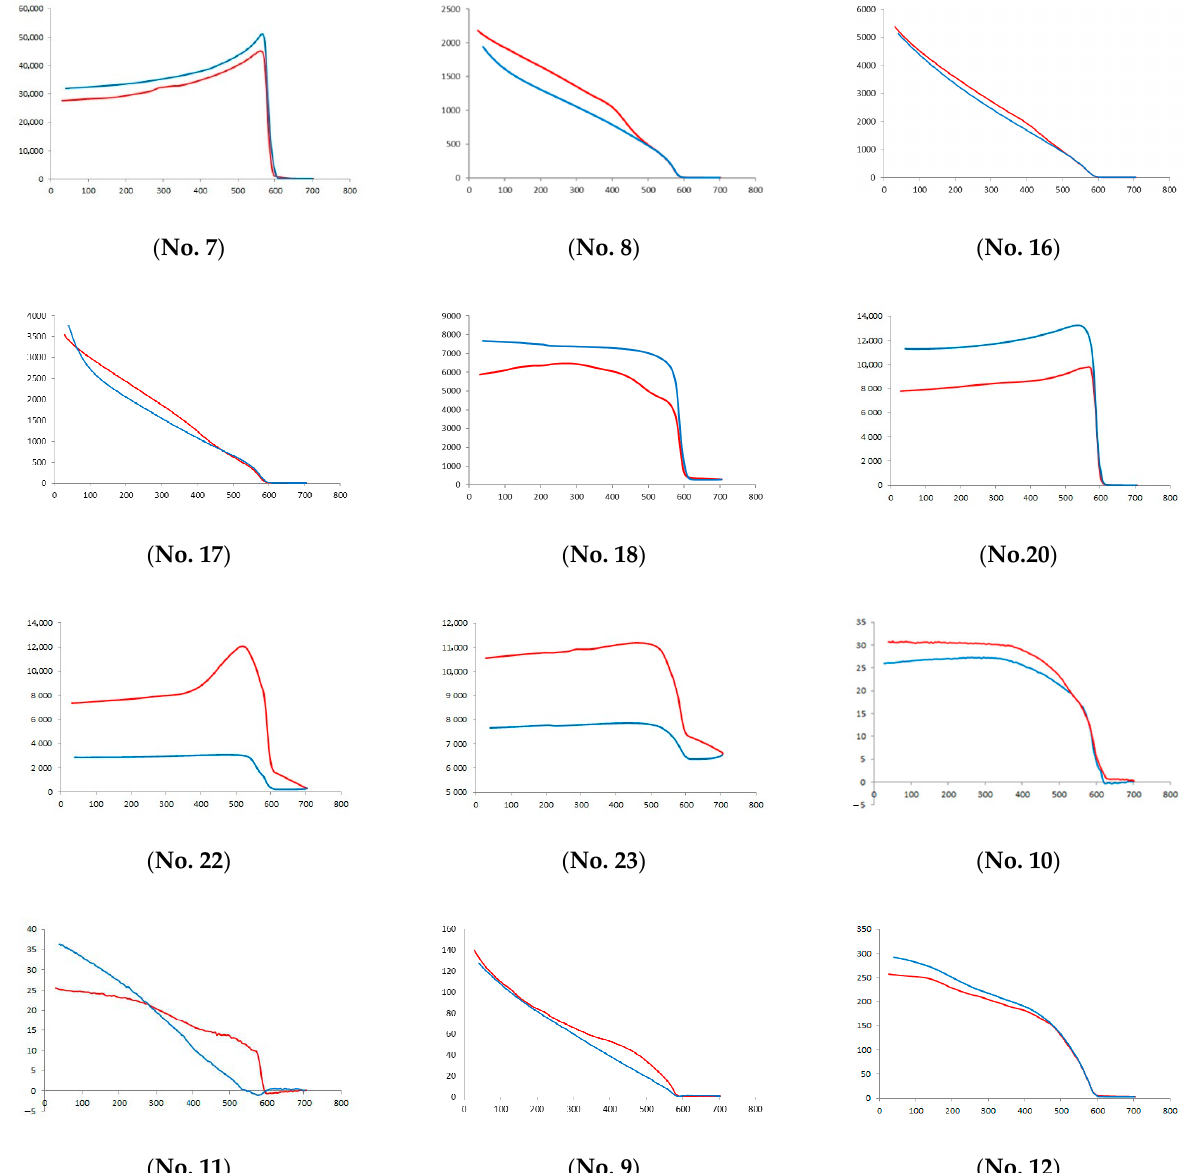
Figure 16. The k-T curves (k ( × 10-5 SI units) is presented on the Y-axis and T ( ◦ C)—on the X-axis) of investigated dust Figure 16. The ĸ -T curves ( ĸ (×10-5 SI units) is presented on the Y-axis and T (°C) — on the X-axis) of investigated dust samples. The heating lines are in red and cooling lines—in samples. The heating lines are in red and cooling lines — in blue.